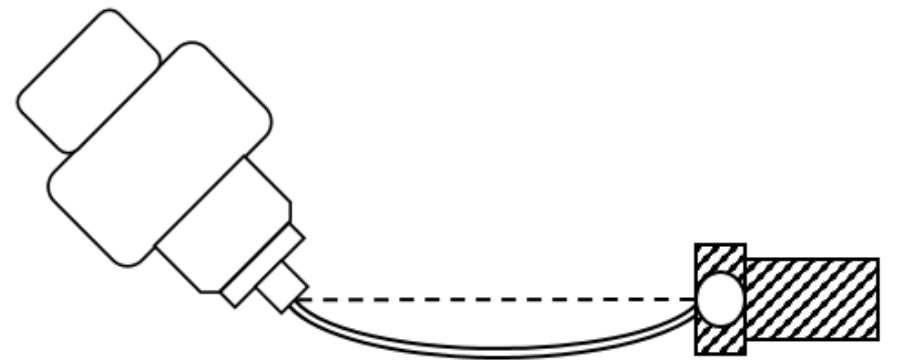
Figure 6. Diagram of Nakamura fatigue test with the rotating-bending machine.